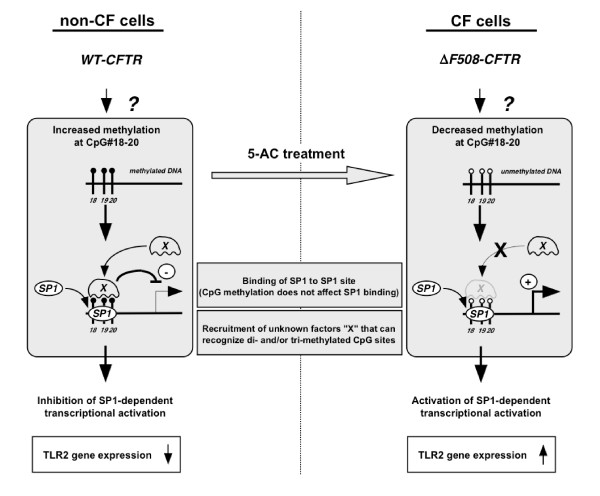
A potential model representing the mechanisms underlying hypomethylation-dependent TLR2 promoter activation in human epithelial cells. Enhanced methylation of the CpG#18-20 site within TLR2 promoter observed in non-CF epithelial cells is followed by the enhanced recruitment of unknown factors "X" that could recognize methylated CpGs and could suppress SP1-dependent transcriptional activation without affecting the binding of SP1 to those CpGs (left panel). 5-azacytidine (5-AC) treatment of non-CF cells leads to the demethylation of CpG#18-20. On the other hand, CF epithelial cells express high level of TLR2 gene through decreased methylation of CpG#18-20, which might abolish the recruitment and activity of factors "X" in these cells (right panel).